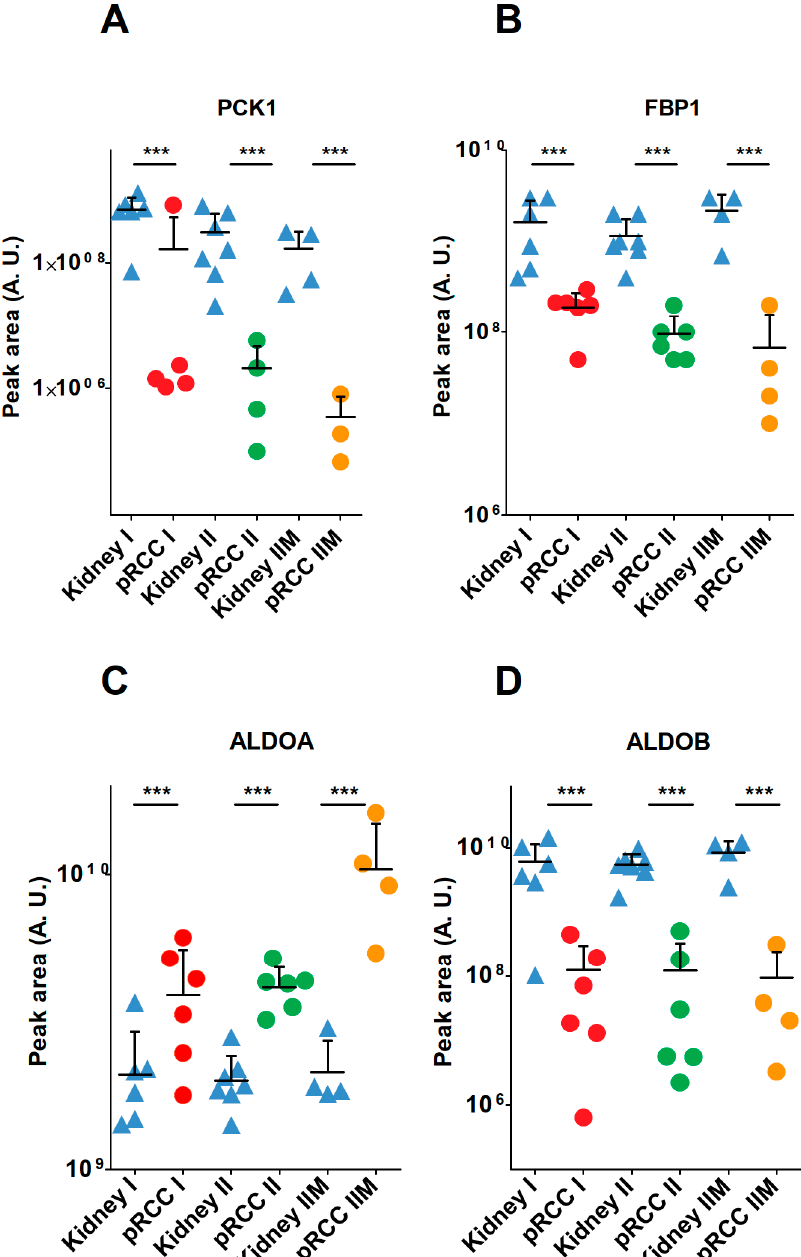
Figure 5. Protein abundances of gluconeogenic enzymes in papillary renal cell carcinoma (pRCC) and normal kidney tissues. ( A ) PCK1, phosphoenolpyruvate carboxykinase 1; ( B ) FBP1, fructose-1,6-bisphosphatase; ( C ) ALDOA, fructose-bisphosphate aldolase A; ( D ) and ALDOB. p -value is: *** p < 0.001 by a two-tailed Student’s t -test.